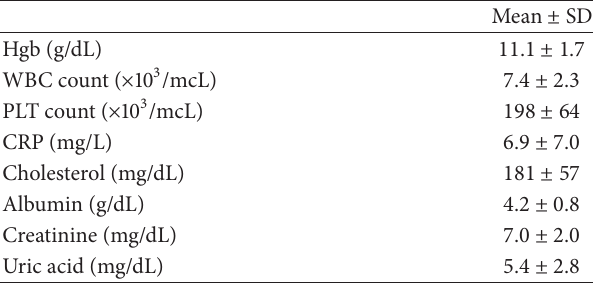
Table 2: Pretransplant recipient blood